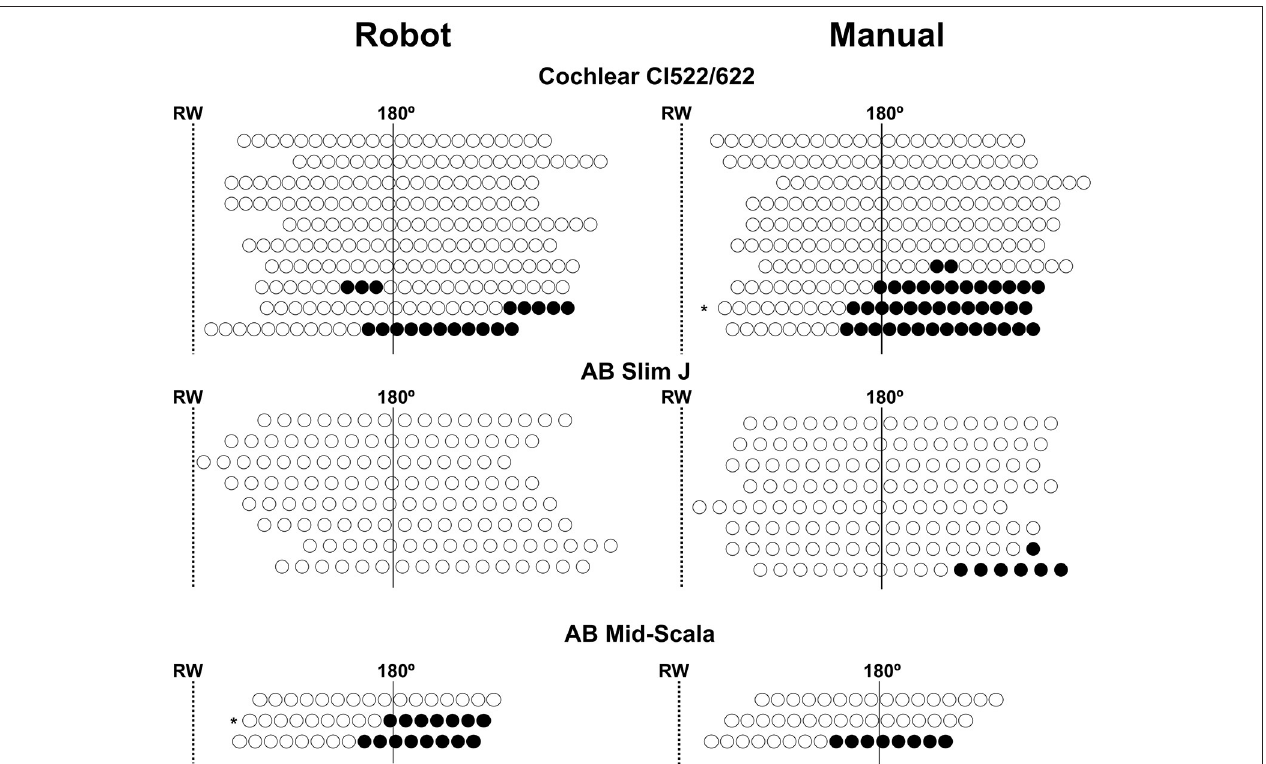
FIGURE 2 | Representation of the position of each electrode following robot-assisted and manual electrode array insertion. The position of the electrode array was adjusted according to the round window position (RW) (dotted line) and 180 ◦ position (continuous line). The translocation rate of the electrode array was similar in both insertion groups, however, the number of translocated electrodes after a robot-assisted insertion was lower than with manual insertion. Unfilled circles: non-translocated electrode, filled circles: translocated electrode. AB, Advanced Bionics; * electrodes inserted through a cochleostomy.